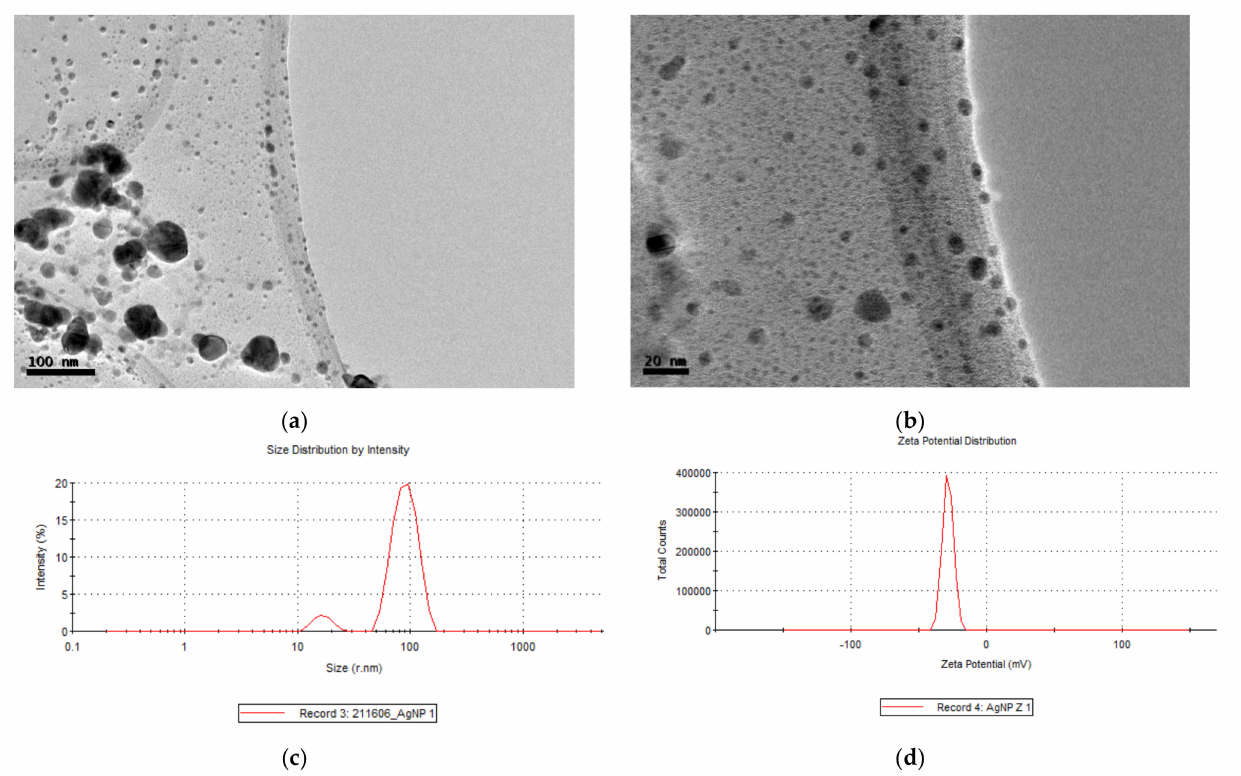
Figure 2. Nanoparticle characterization by microscopy and Z potential. ( a ) and ( b ) TEM micrographs, ( c ) size distribution, and ( d ) Z potential of